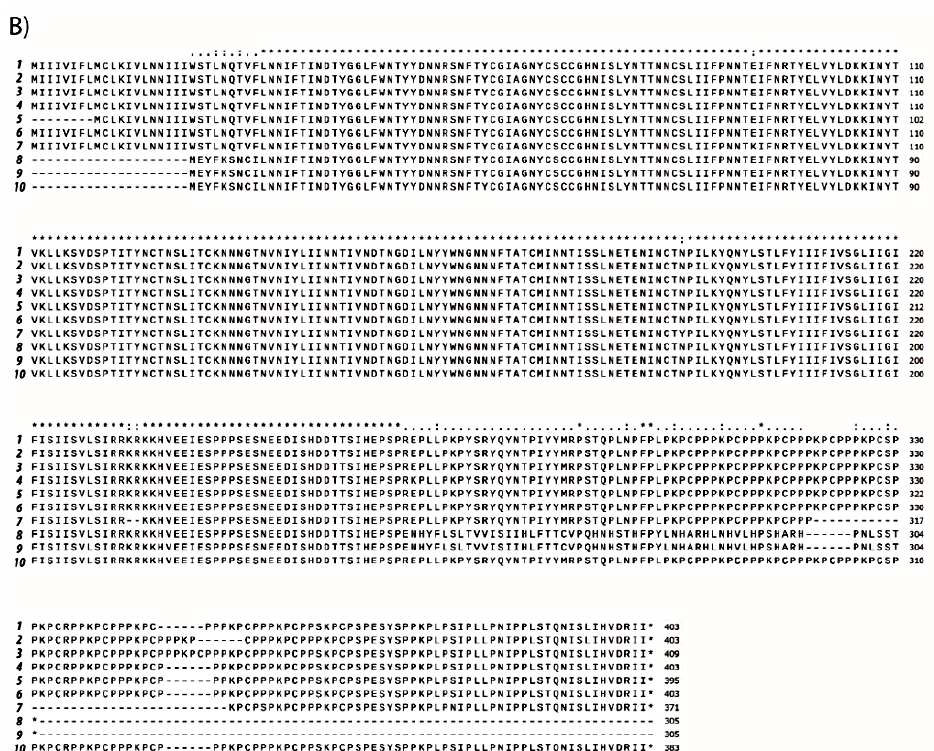
Figure 6. Multiple nucleotide ( A ) and amino acid alignment ( B ) of EP402R sequences corresponding to the genotype I strains numbered 1–9 and Armenia / 07 / CBM / c4 strain performed using ClustalW. A: Nucleotide alignment of EP402R sequences show that ORF in strains 1–4 and 6 are codified in the third reading frame (ATG in red) whereas ORF for strain 5 and 8–10 is codified in second reading frame (ATG in blue). T deletion identified in Arm / 07 / CBM / c4 is highlighted by a red square. B: Amino acid alignment of EP402R sequences corresponding to the indicated